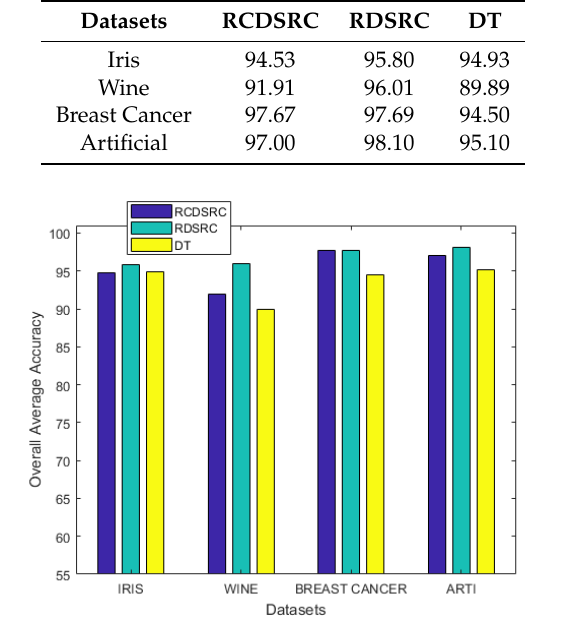
Figure 7. The average